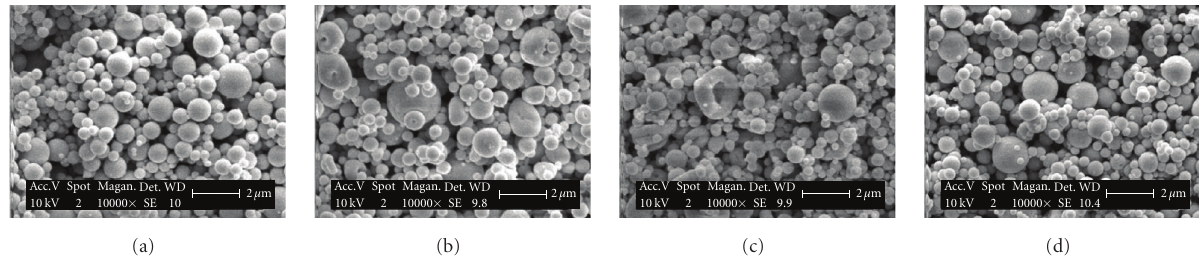
Figure 4: SEM images of NaTaO 3 powders synthesized by spray pyrolysis with variation of precursor preparation temperature: (a) 298 K, (b) 313 K, (c) 333 K, (d) 353 K (mean residence time = 2.25 seconds, spray pyrolysis temperature = 1173 K, precursor concentration = 0.125 M, carrier gas (air) flow rate = 4 L/min, Na/Ta = 1.00).